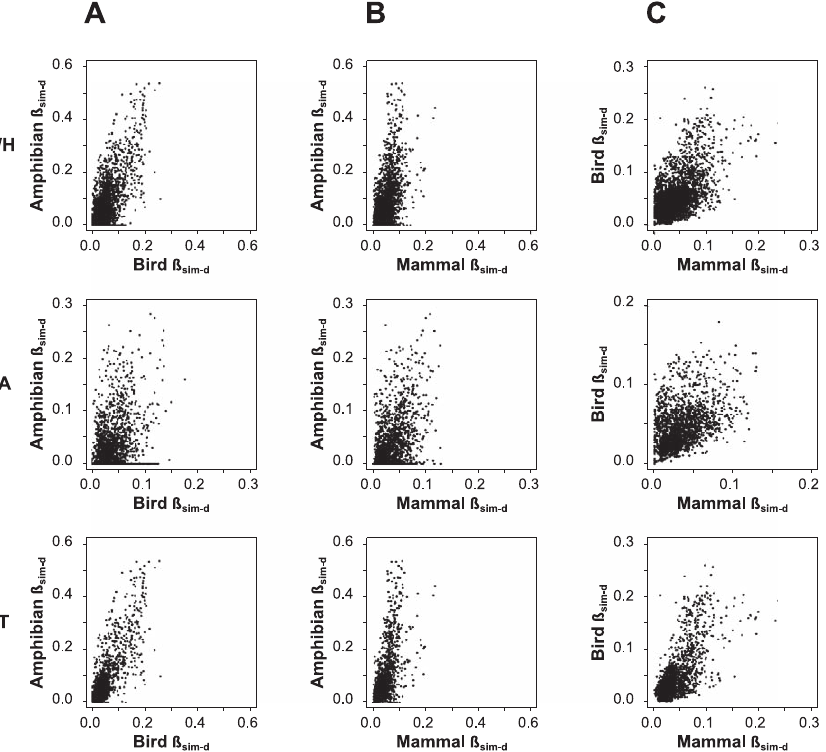
Figure 2. Cross-Taxon Relationships in Beta-Diversity of Amphibians, Birds, and Mammals Scatterplotsshowtherelationshipsbetween b sim-d foreachpairoftaxawithintheWesternHemisphere(WH,toprow),theNearcticrealm(NA,middlerow), and the Neotropical realm (NT, bottom row). The axes for each plot are scaled according to the maximum b sim-d value of the two taxa within the extent specified. Note that maximum values are much greater for amphibians than for either birds or mammals and that all three taxa reach higher rates of assemblage change in the Neotropics than in the Nearctic. (A) Amphibians and birds. (B) Amphibians and mammals. (C) Birds and mammals.